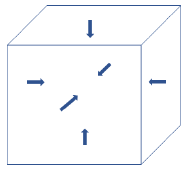
Figure 9. Flexoelectric polarization near each surface of a BaTiO 3 nanocube. At each surface of a nanocube, another nanocube is attached in an ordered assembly. Reprinted with permission from Ref. [166]. Copyright 2020, IOP Publishing.